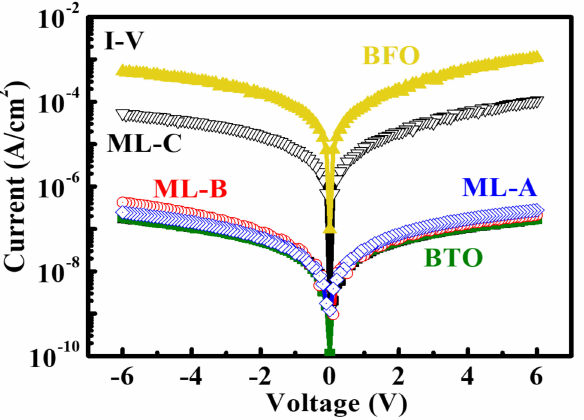
Figure 3. The comparisons of the I-V curves on the pure 100 nm BaTiO 3 (BTO) thin film and pure BiFeO 3 (BFO) thin film with our designed multi-layer BaTiO 3 (BTO)/BiFeO 3 (BFO) structures from Condition A (ML-A) to Condition C